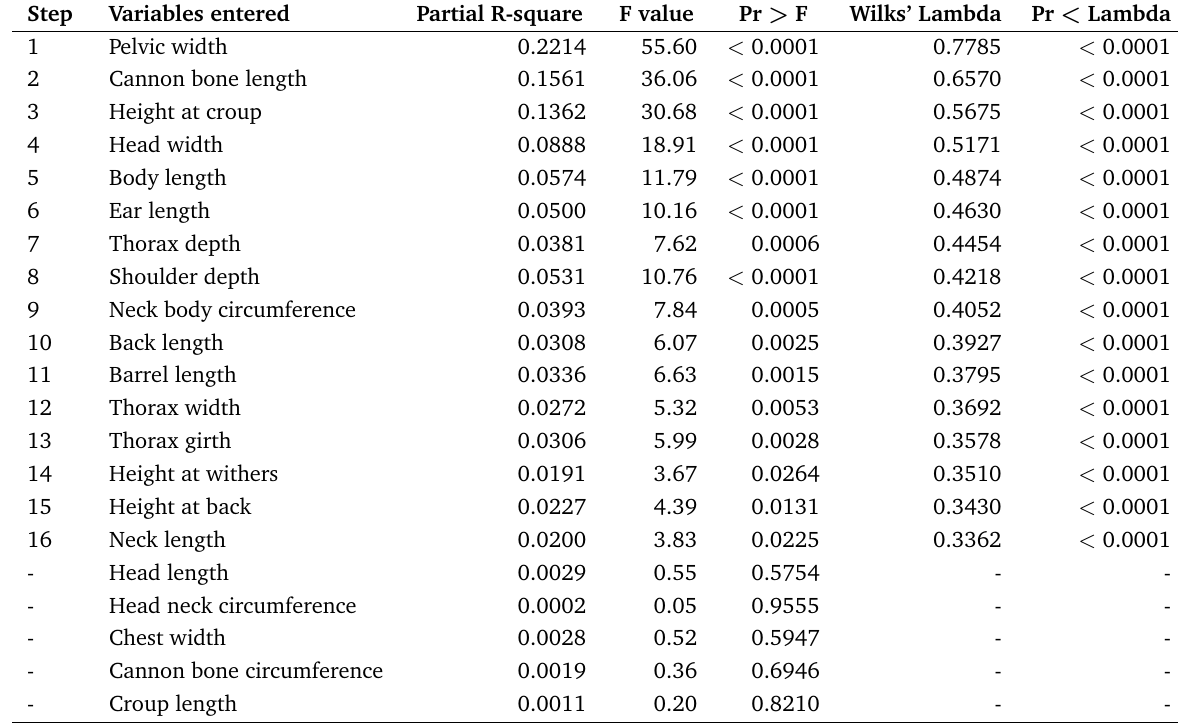
Table 9. Summary of the stepwise discriminant function analysis. Traits are listed in ascending order used in discriminating the horse populations from different locations.